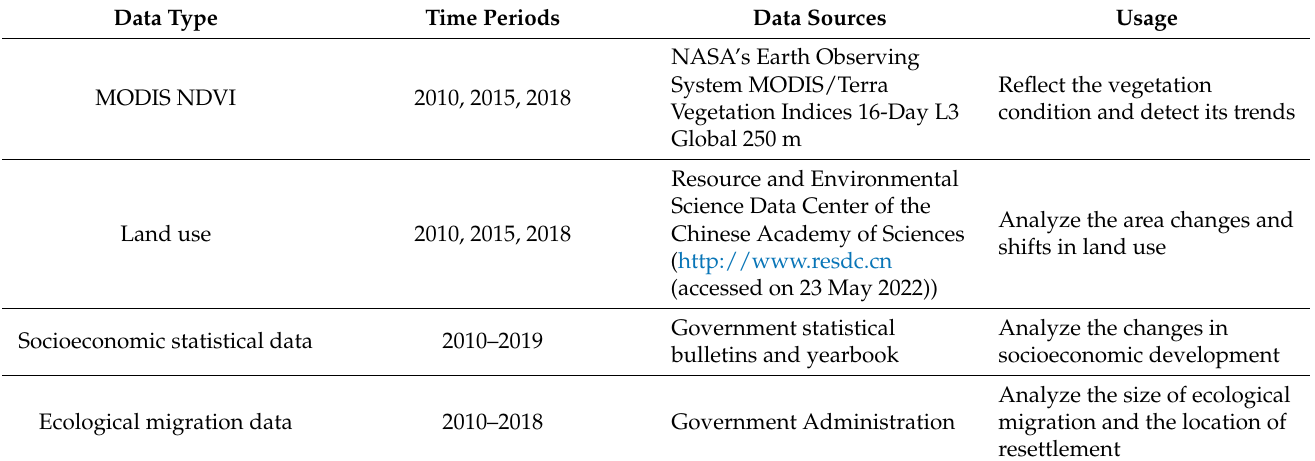
Table 1. Summary of data